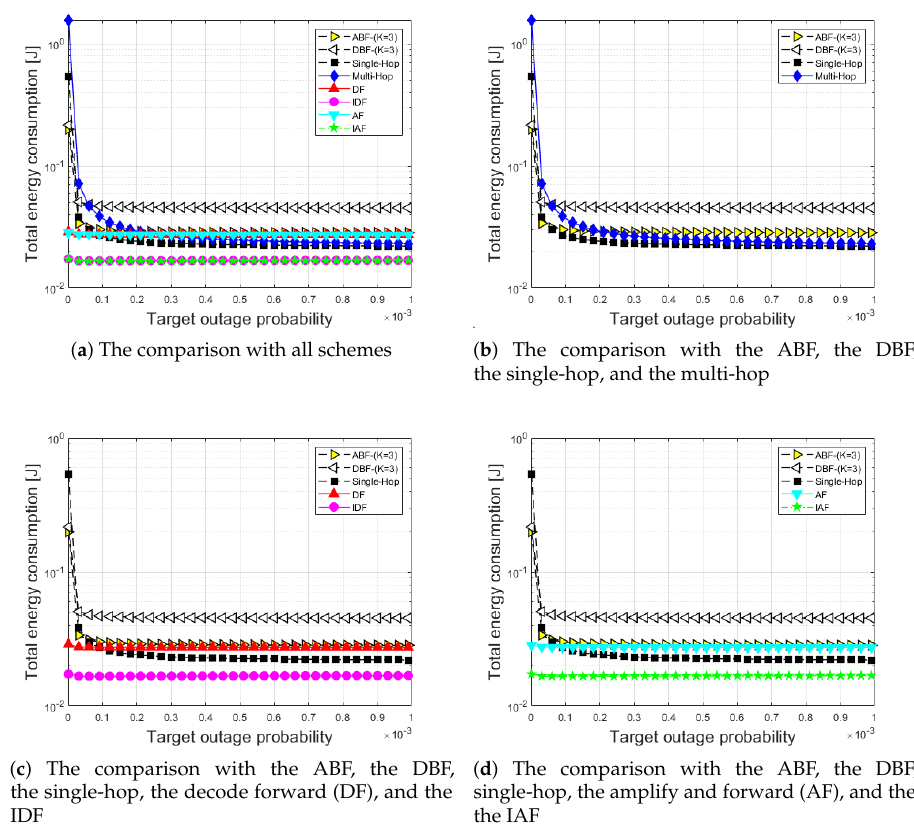
Figure 8. Target outage probability vs. total energy consumption.